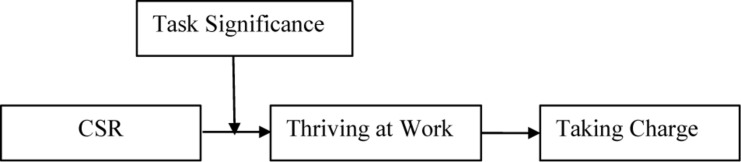
Theoretical model.